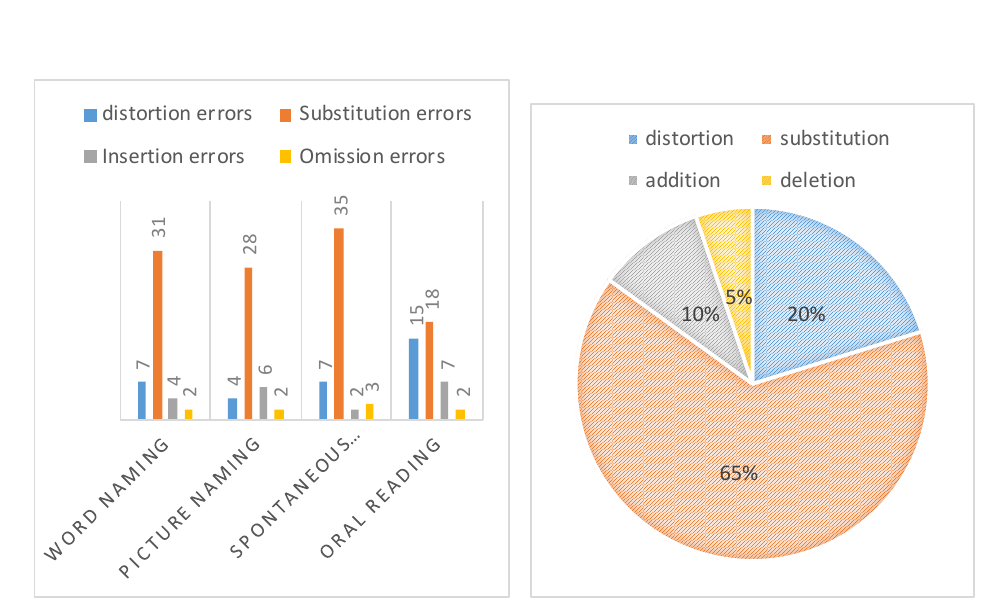
Figure 2. The degree of Phonological Errors of